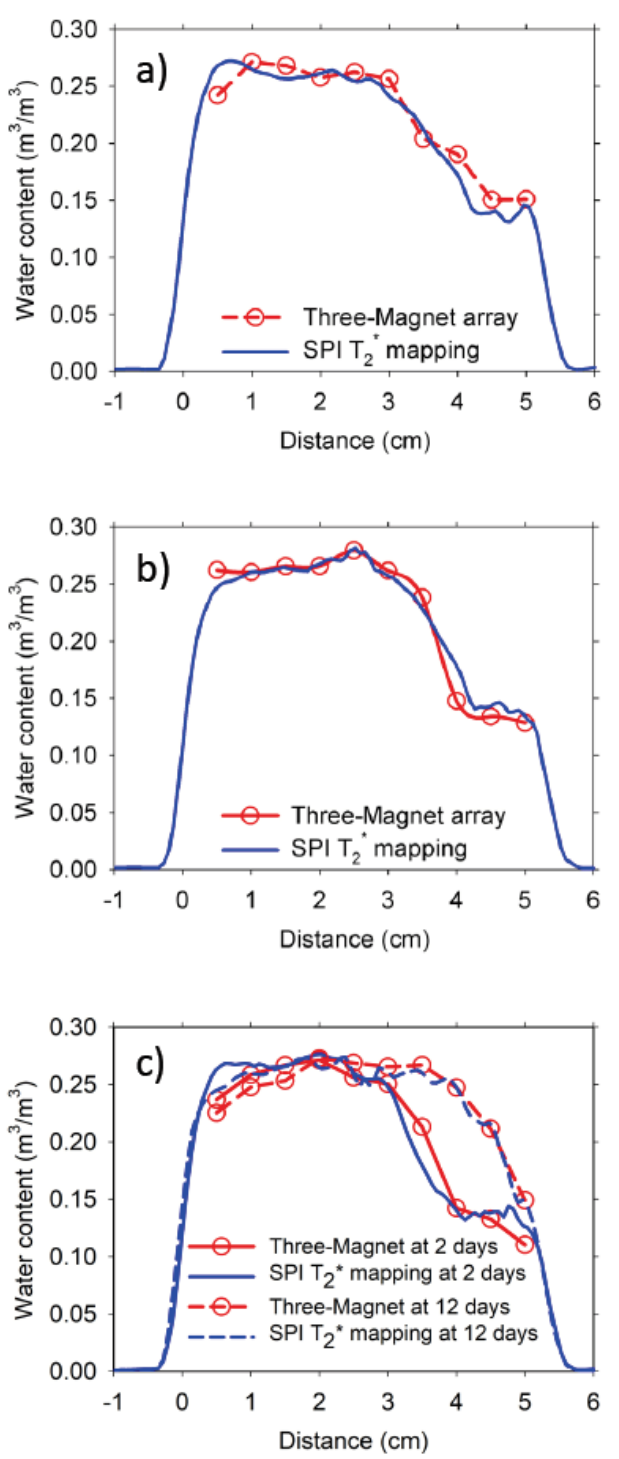
Figure 8. Moisture content profiles obtained with the three-magnet array with an elliptical surface RF coil, and the T 2 * mapping with the SPI technique on three 0.60 w/c ratio mortar samples, ( a ) and ( b ) at 2 days of water absorption, and ( c ) at 2 and 12 days of water absorption.